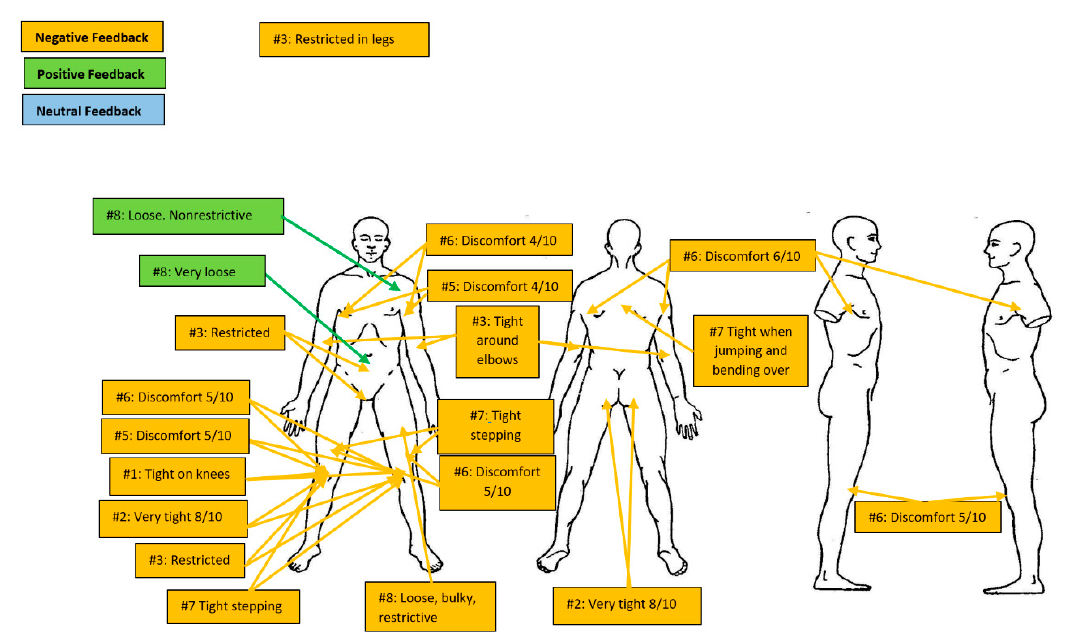
Figure 12. Subjective feedback on Variant 1 (# signifies participant number; scores out of 10 signify discomfort level).